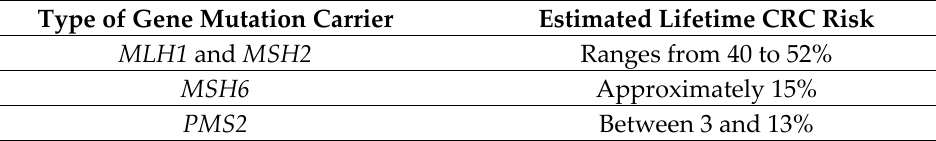
Table 3. Lifetime risks of CRC at 70 years old